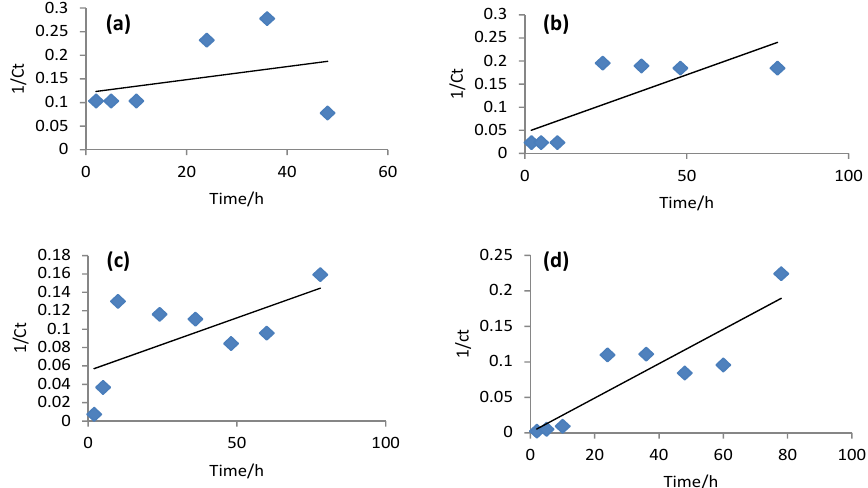
Fig. 6: 2 nd order kinetic plot at different dye concentrations: (a) 25 mg/L, (b) 100 mg/L, (c) 200 mg/L and (d) 500 mg/L Table 1: Rate constants and regression coefficients of kinetic models Constants